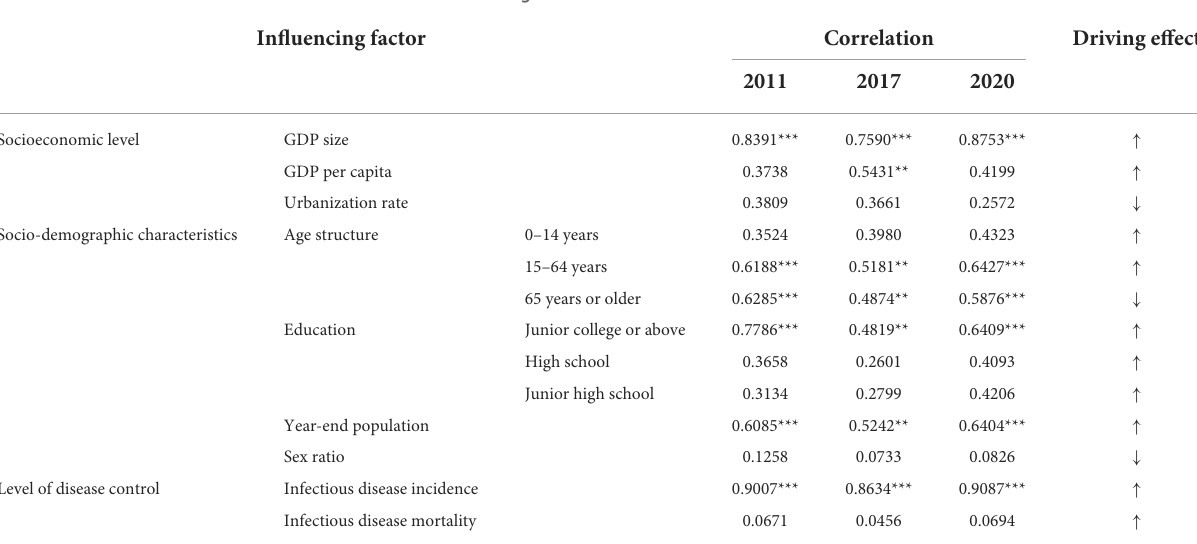
TABLE 5 Correlation coefficient between OAV and its influencing